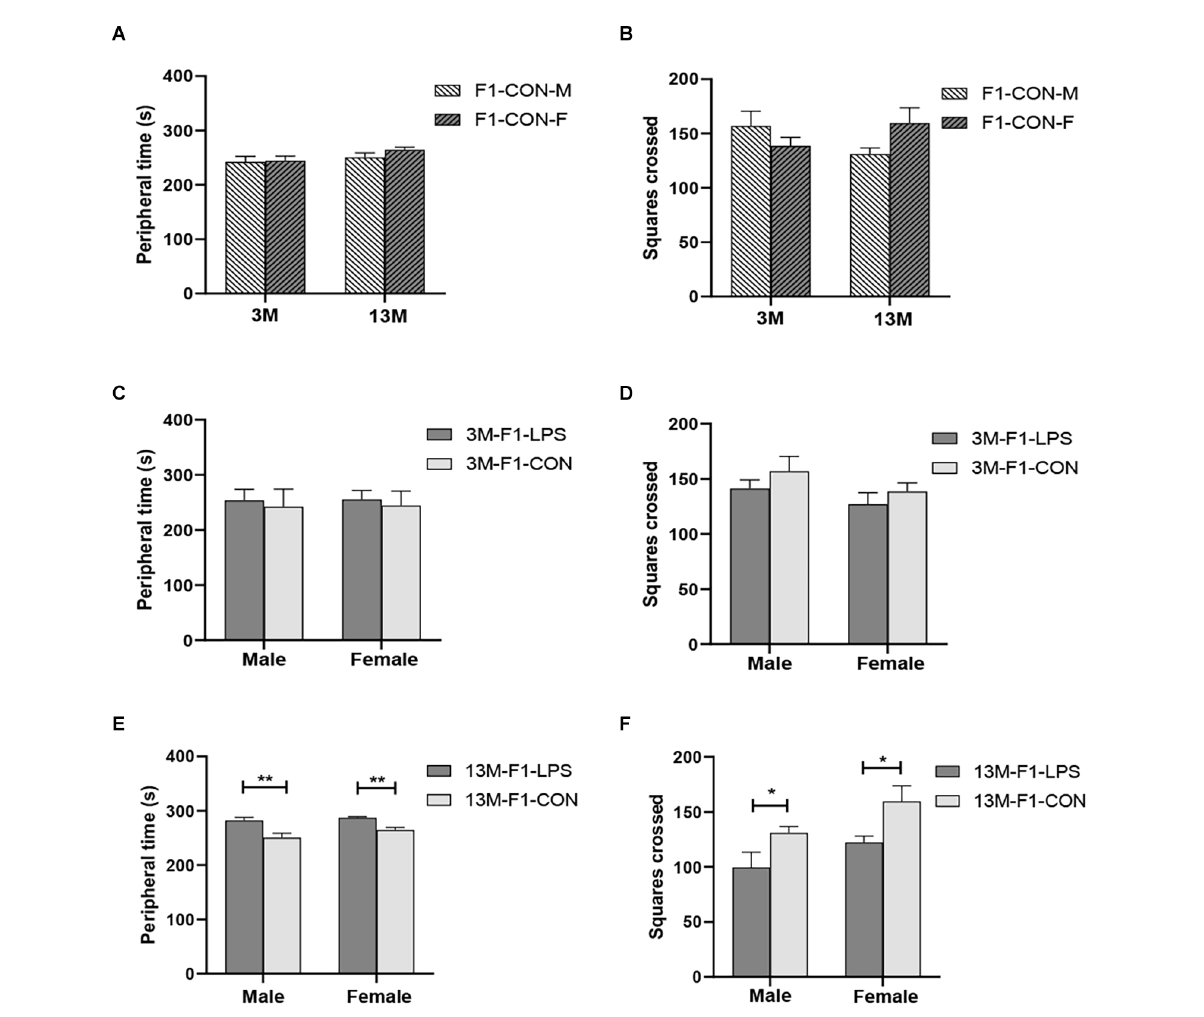
FIGURE2 The results of the open field test in the F1 generation. (A,B) Peripheral time and the number of squares crossed at different ages in control groups. n = 10 male or female mice/group. Error bars = standard error of the mean (SEM); * P < 0.05, ** P < 0.01 compared with the 3-month-old group. (C,E) Peripheral time and (D,F) number of squares crossed for 3- (3 M) and 13-month-old (13 M) CD-1 mice in the different treatment groups. n = 10 male or female mice/group. Error bars = SEM. * P < 0.05, ** P < 0.01. CON-M, male mice exposed to saline in utero ; CON-F, female mice exposed to saline in utero ; F1-CON, F1 mice exposed to saline in utero ; F1-LPS, F1 mice exposed to prenatal